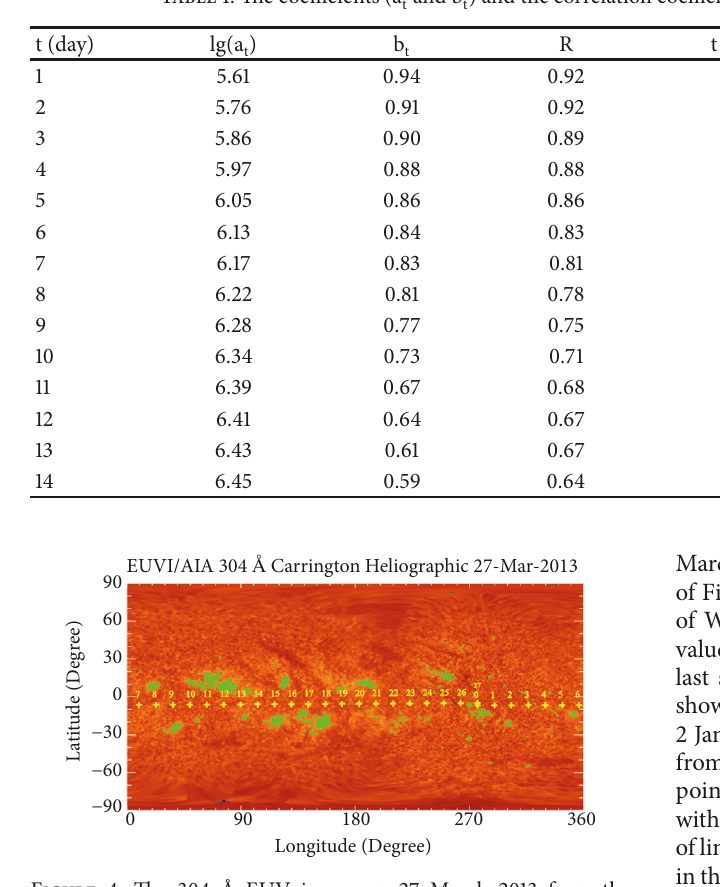
Figure 4: The 304 ˚A EUV image on 27 March 2013 from the combination of the 304 ˚A data from SDO/AIA with the data from thetwin STEREO/EUVI. Thecoordinateis CarringtonHeliography. The green regions represent the SRs of F 10.7 , in which the pixel intensity is greater than or equal to 10 3.2 DN/s. The gold plus signs representthe projected position of Earth at 27 March 2013 (in day 0) and within 1-27 days